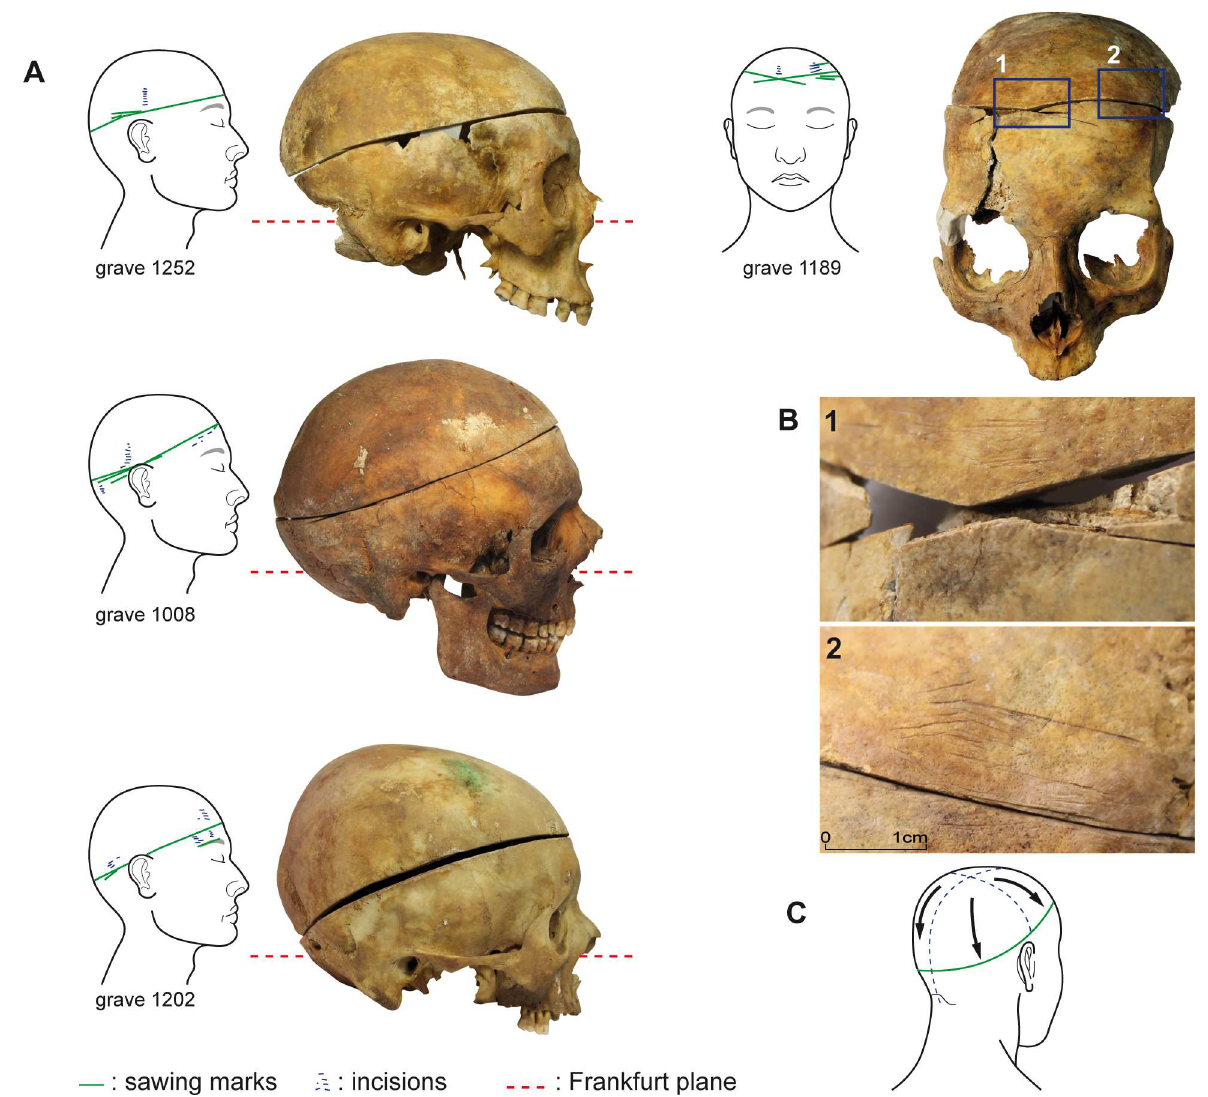
Fig 4. Craniotomies. (A) Examplesof subhorizontal to subobliquecraniotomies from the Jacobins’convent. (B) Details of bone lesions from the skull in grave 1189: (1) sawingmarks, (2) fine groovesdue to the removalof the teguments. (C) Illustration of Dionis’s recommended process